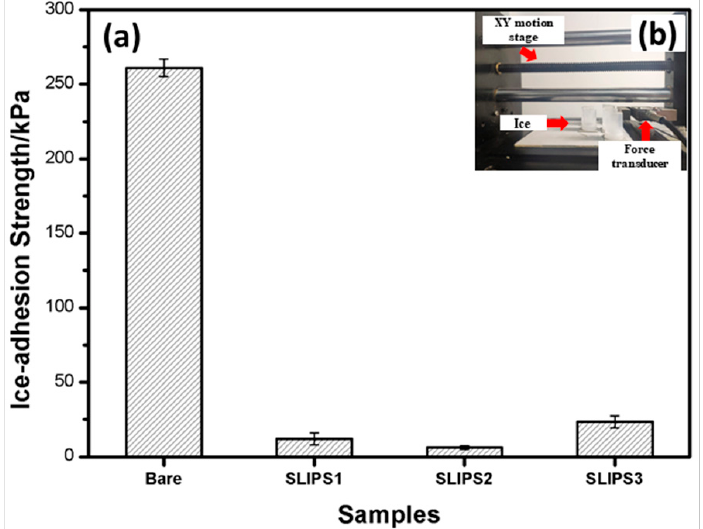
Figure 4. ( a ) Ice-adhesion strength of bare sample, SLIPS1, SLIPS2 and SLIPS3, which were tested at –20 °C. This inset ( b ) showed the ice adhesion test platform.